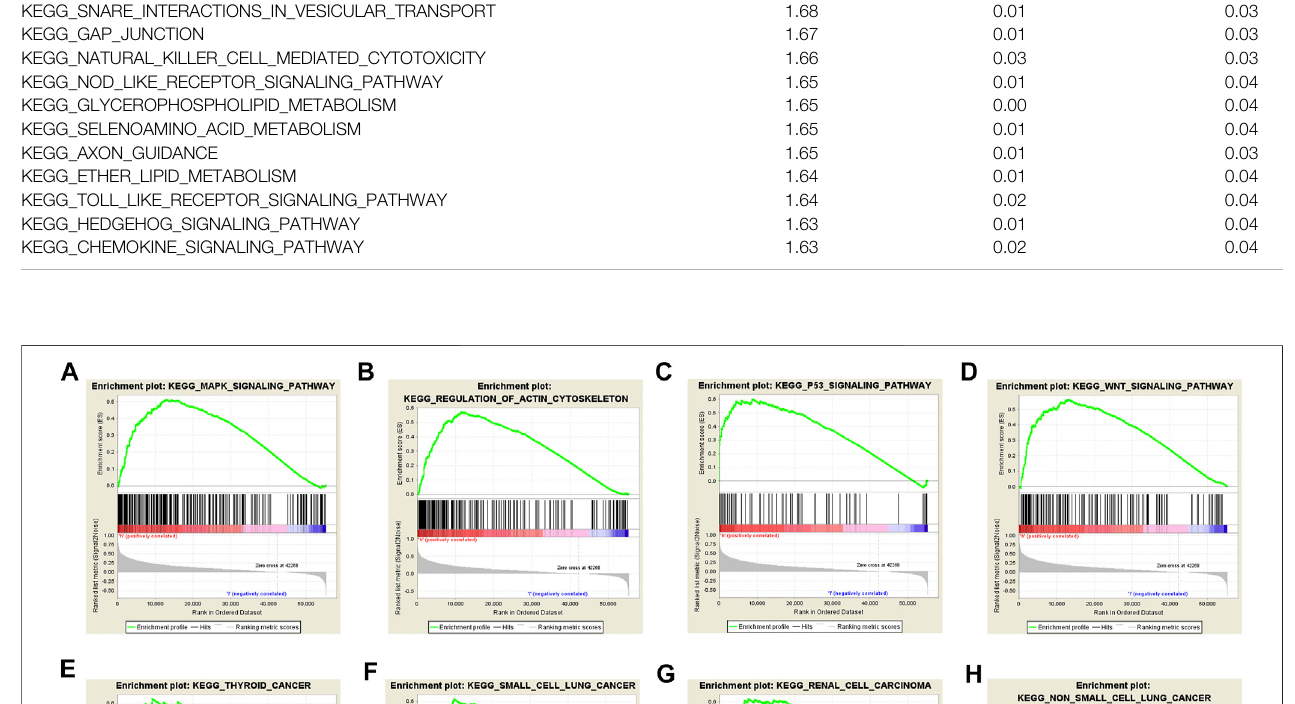
Atlas database. As indicated in Figure 6A , the DEPDC1B protein was strongly expressed in liver cancer, compared with that in other cancers using HPA072558 antibody (Atlas Antibodies